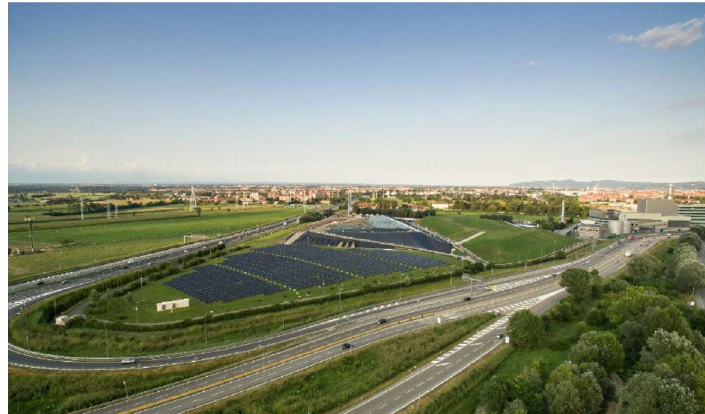
Figure 3. Photo of the Barricalla landfill.